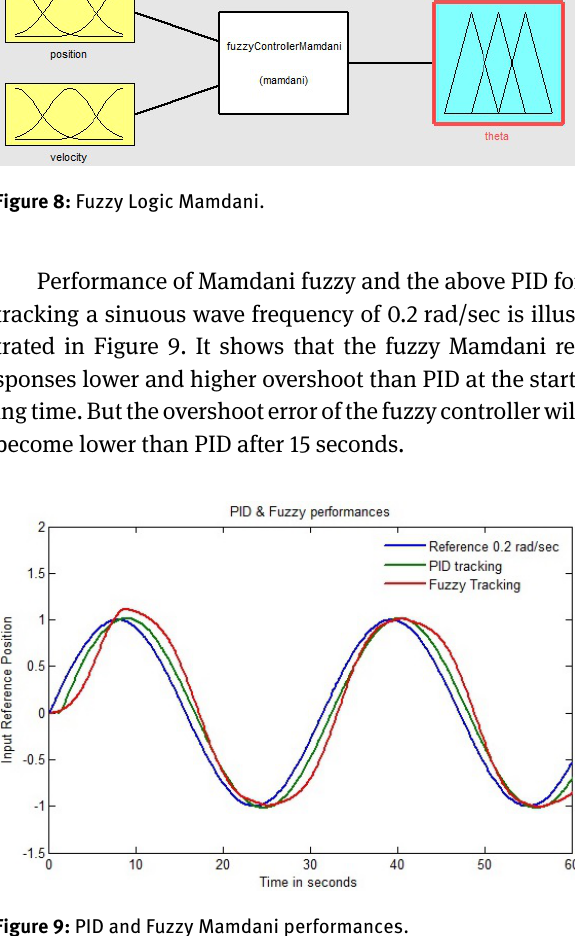
Figure 9: PID and Fuzzy Mamdani